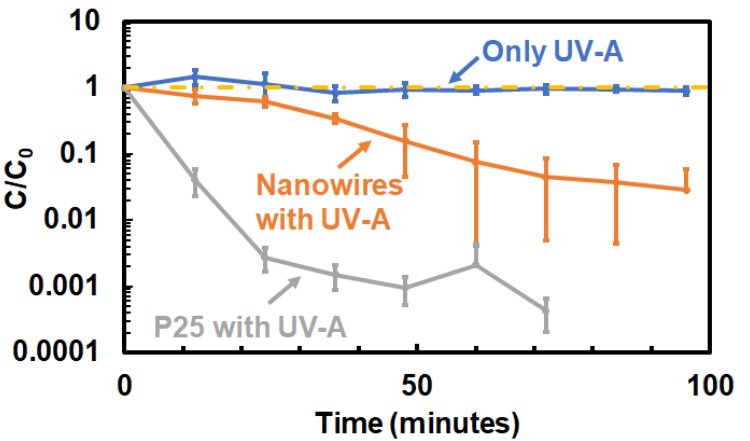
Figure 2. E. coli inactivation in the benchtop water disinfection system built for processing 15.14 liters (4 gallons) per minute of water. The plot indicates that Aeroxide ® P25 nanoparticles exhibit faster disinfection kinetics relative to that obtained using TiO 2 porous nanowires. The photocatalyst concentration in both cases was 0.1 g/L.